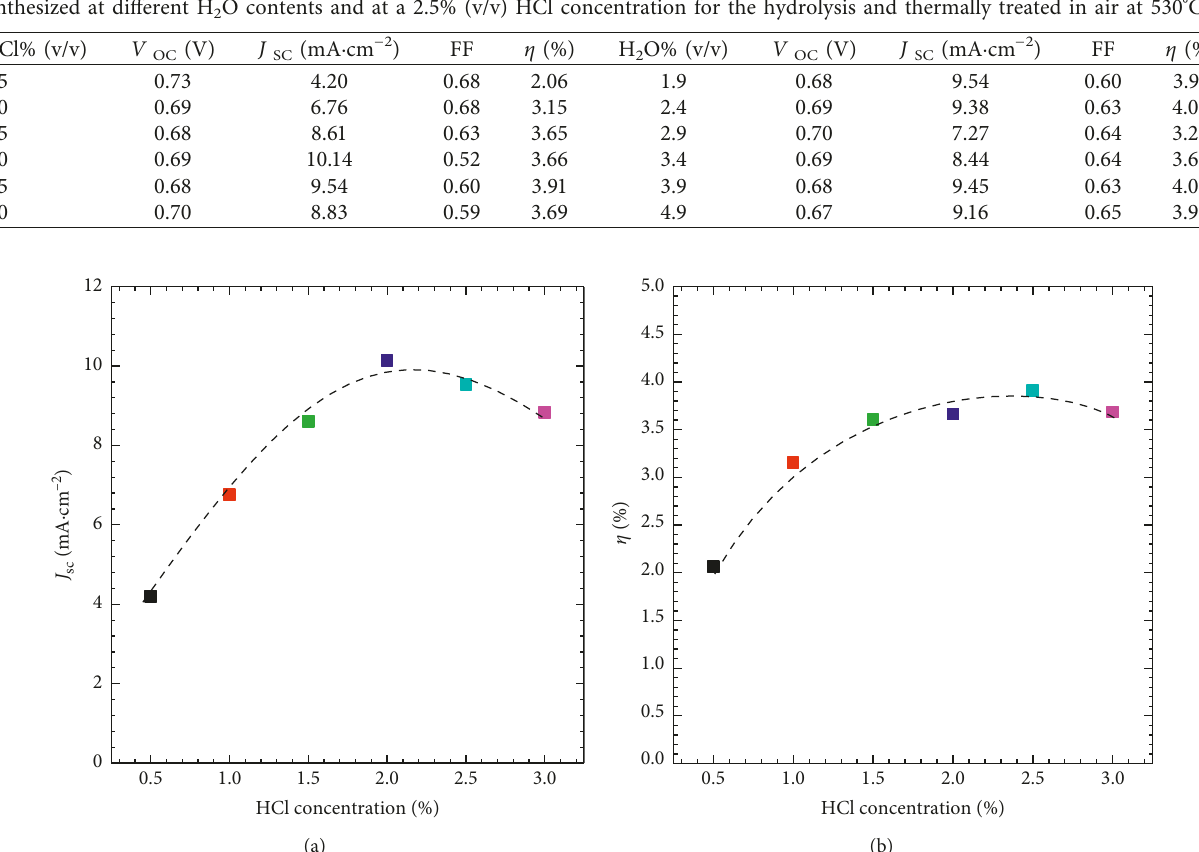
Figure 10: (a) Behavior of the short-circuit current J SC and (b) conversion efficiency as a function of the concentration of HCl for the